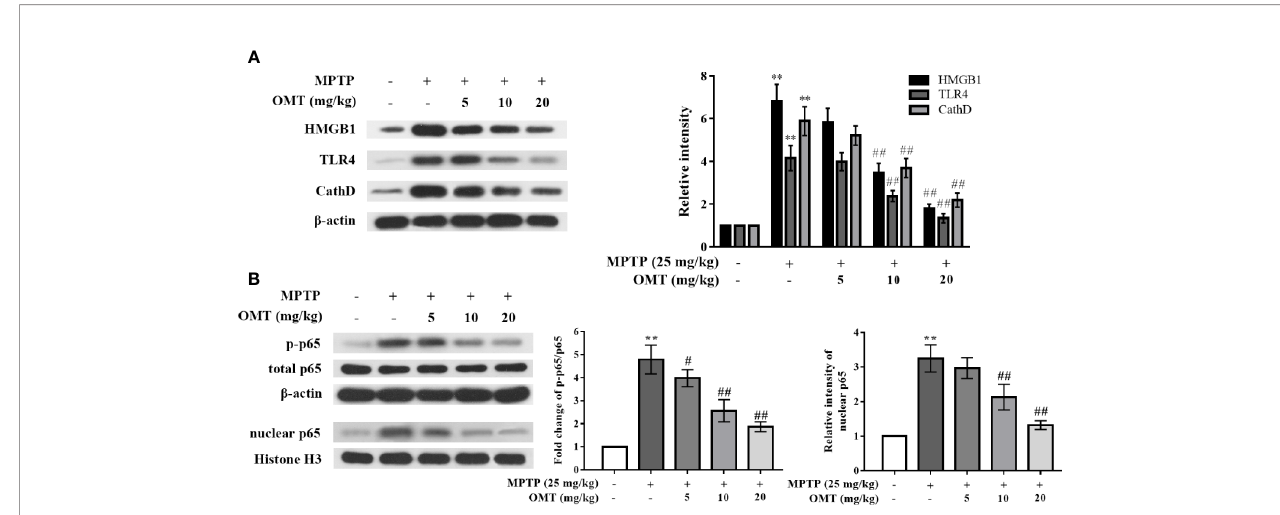
FIGURE 3 | OMT down-regulated Cathepsin D (CathD) expression and inhibited HMGB1/TLR4/NF- k B signaling pathway in MPTP-induced PD mice model. (A , B) The expression levels of CathD, HMGB1, TLR4 (A), p-p65, and total p65 whole cell expression as well as p65 nuclear expression (B) in midbrain of MPTP-induced PD mice were tested by Western blot analysis. The data are presented as mean ± SEM. **p < 0.01 vs. Control group; ## p < 0.01 vs. MPTP group # p < 0.05 vs. MPP+-treated cells. ANOVA with Bonferroni ’ s post-hoc